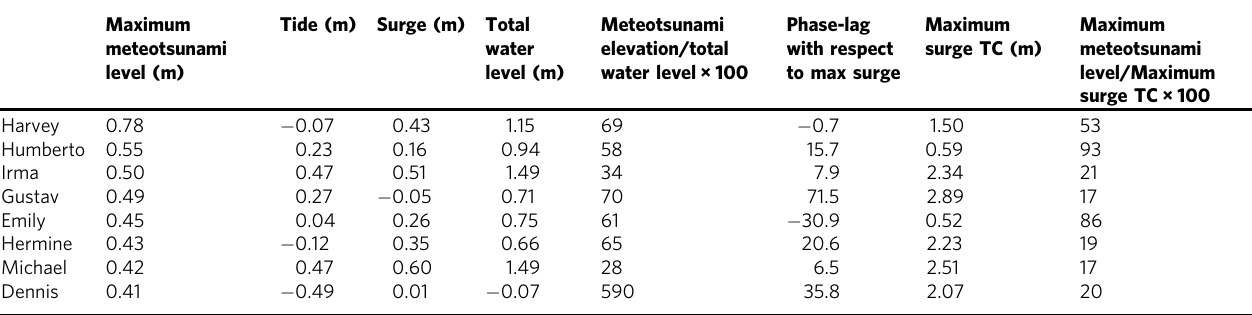
Table 2 Tropical cyclone-induced meteotsunami effects on total water